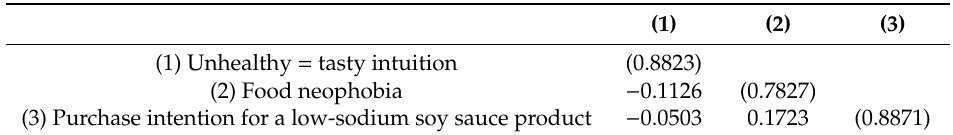
Table 7. Correlations of the latent variables and the square root of the average variance extracted from the second experiment: yogurt